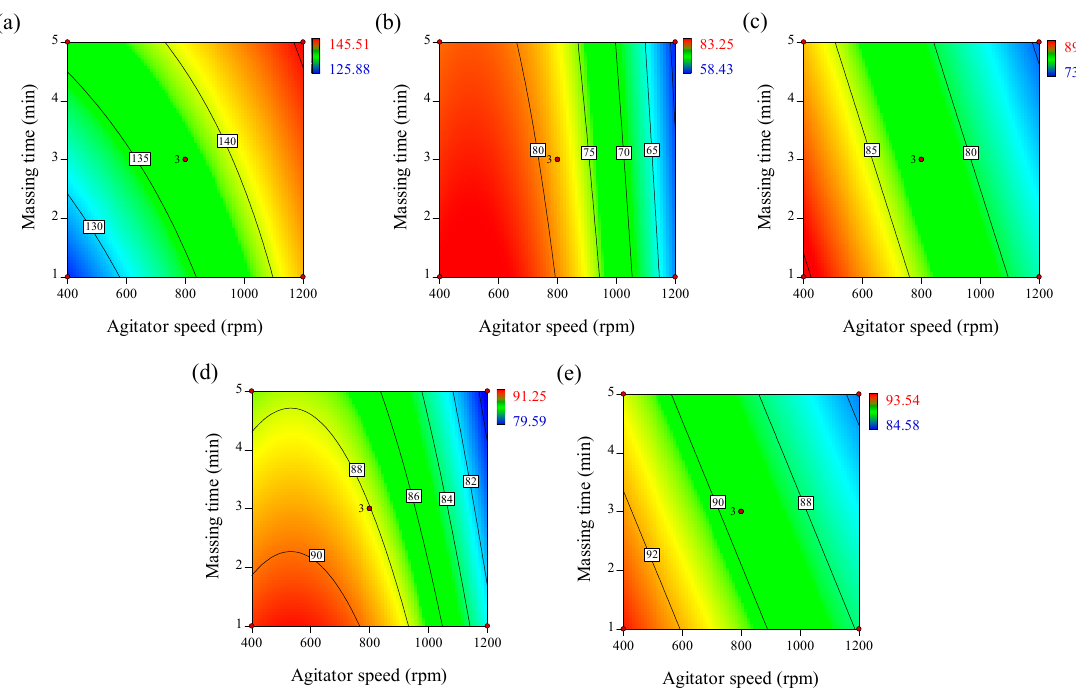
Figure 3. Contour plots correlating response factors (CQAs) to optimize process parameters of high-shear wet granulation for the telmisartan test tablet. ( a ) Tensile strength, ( b ) % dissolution at 5 min, ( c ) % dissolution at 10 min, ( d ) % dissolution at 15 min, and ( e ) % dissolution at 30 min.